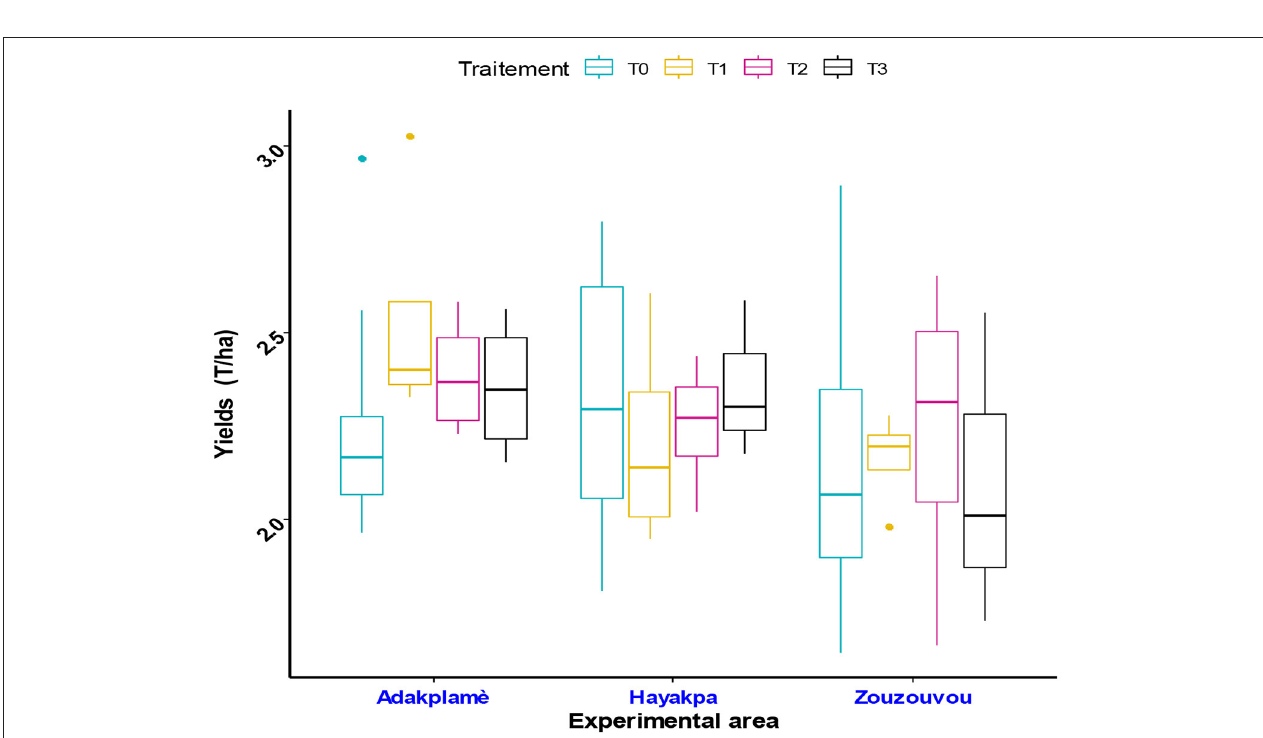
FIGURE 8 | Maize grain yield as a function of treatment and area. T 0 :100% NPK + Urea; T 1 : clay + P. putida + ½ NPK + Urea, T 2 : peat + P. putida + ½ NPK + Urea, T 3 : clay-peat + P. putida + ½ NPK +